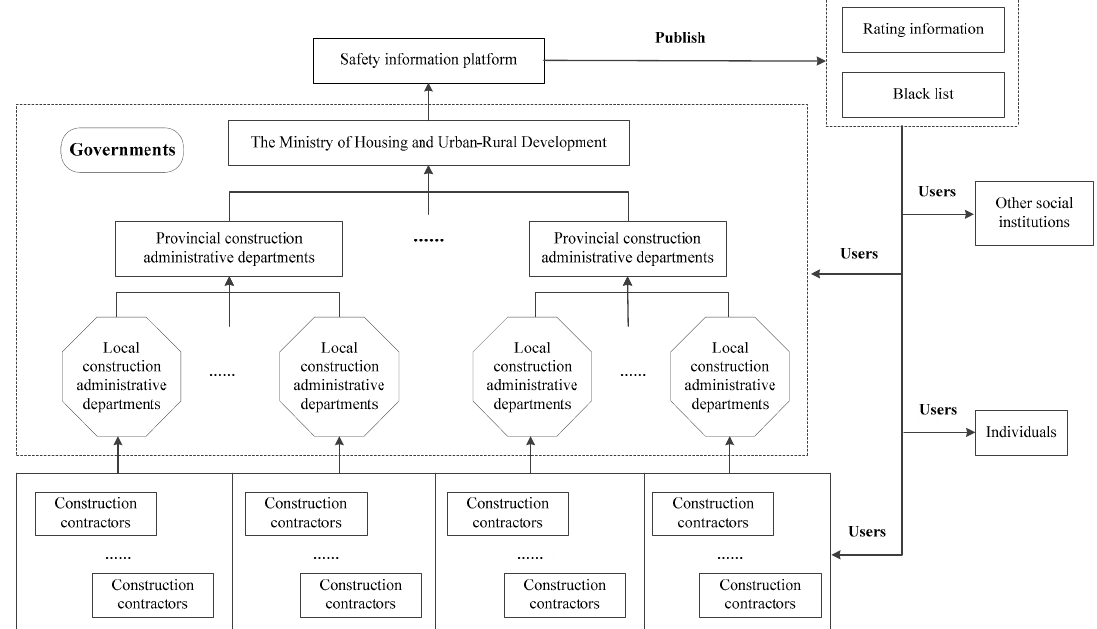
Figure 2. Structure of safety information system in construction industry.